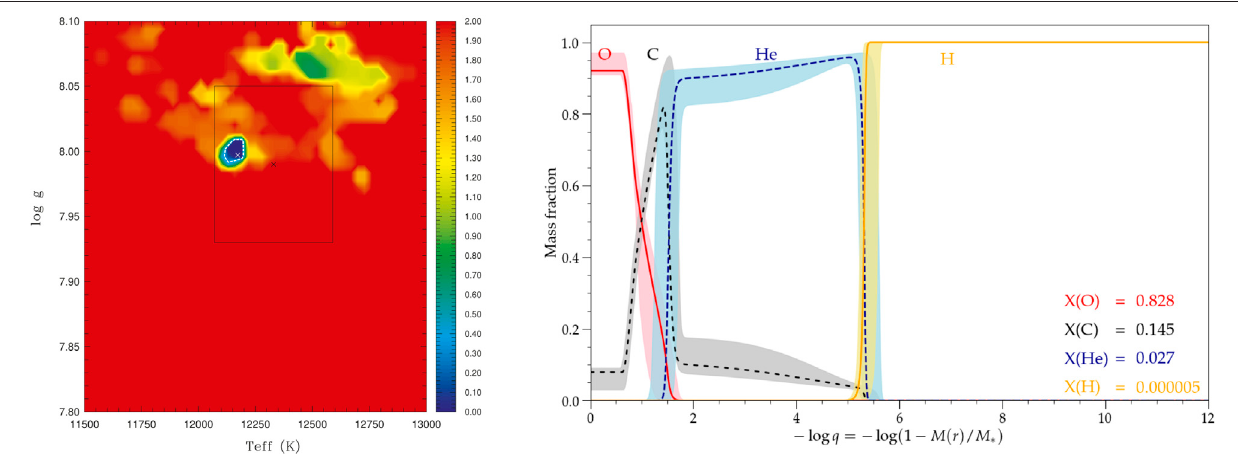
FIGURE 5| Leftpanel: Map ofthe merit function (cid:2) S 2 projected onto the log g − T eff plane for models ofSDSS J1136 +0409, on alogarithmicscale. The location of theoptimalmodelinthisplaneisindicatedbyawhitecross.Thewhitedottedcurvesdelimittheregionswherethemeritfunctionhasvalueswithinthe1 σ con fi dencelevel relative to the best- fi tting solution. The black cross surrounded by the solid black box indicates the independent spectroscopic solution and its 1 σ uncertainties. Right panel: We show the derived chemical strati fi cation. The graph shows the distribution of oxygen (in red), carbon (in grey), helium (in blue), and hydrogen (in orange) obtained from the optimal seismic model. The estimated 1 σ errors (shaded areas around each curve) are derived from the probability distributions calculated during the optimization process. The x axis shows the fractional mass depth (with log(q) = 0 corresponding to the centre of the star). The total mass fractions for each element are indicated at the bottom right.